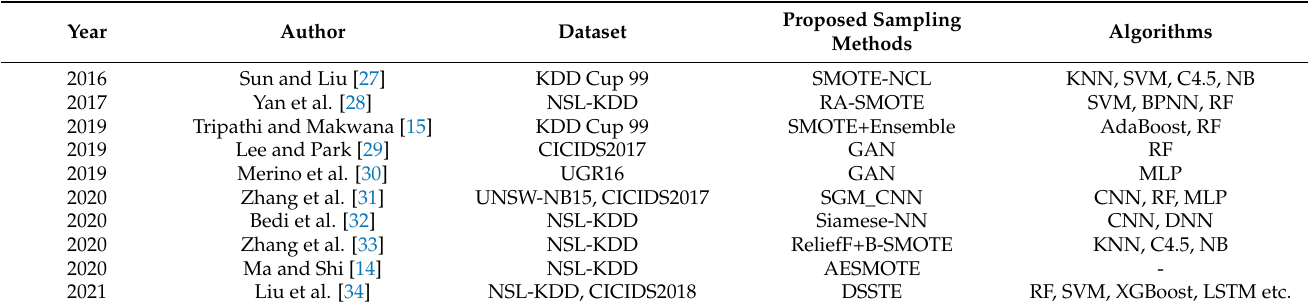
Table 3. Related studies on imbalance handling of intrusion detection